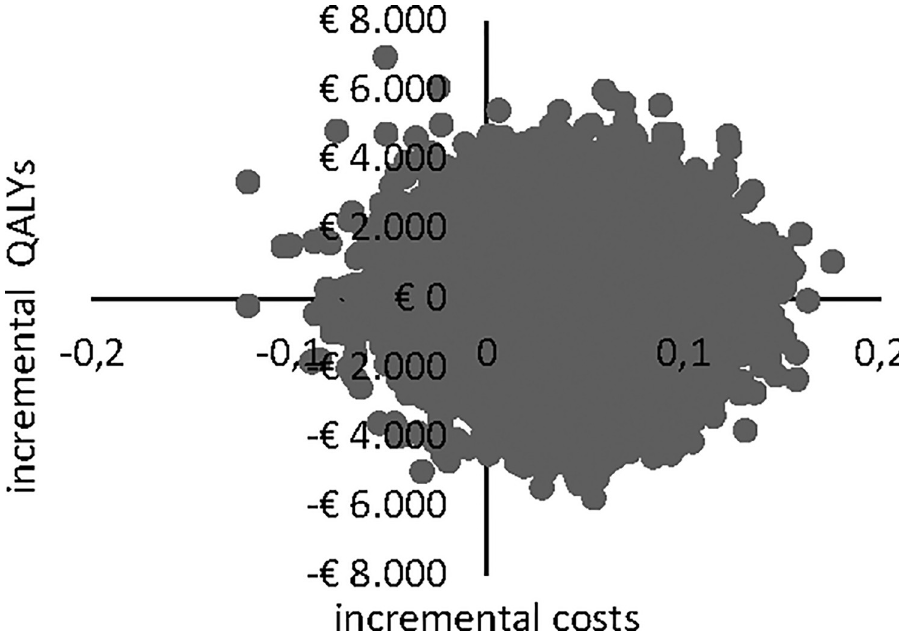
Fig 3. CE plane for societal perspective.